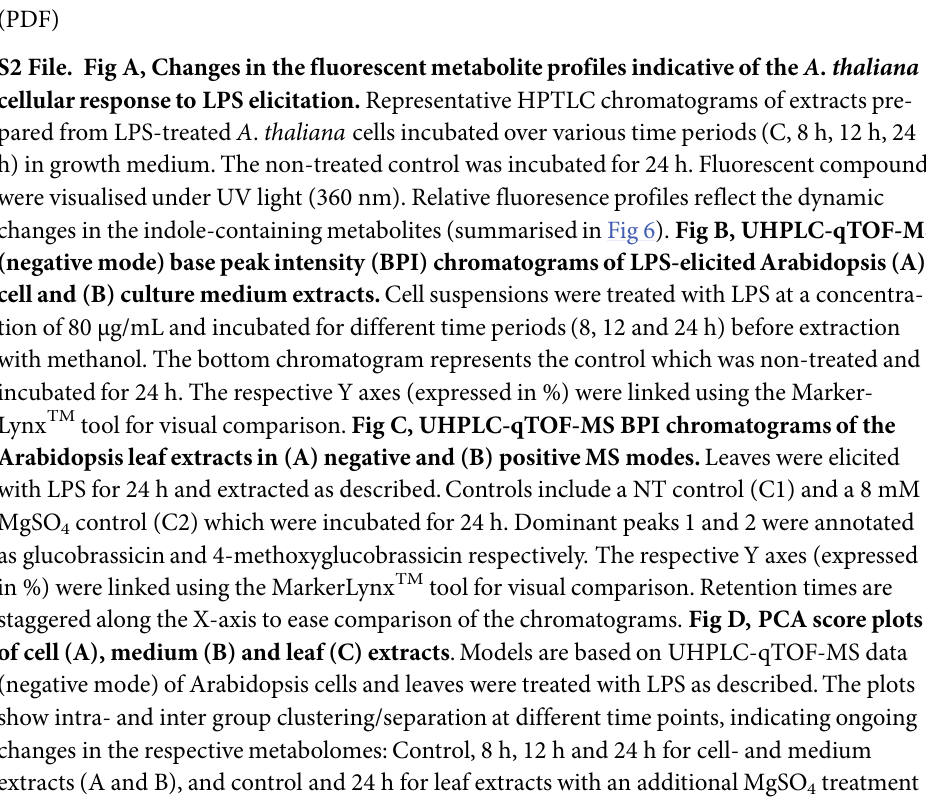
Table C, Quality and reliability of computed PCA and OPLS-DA models. Table D, Table of systematic- and common names for glucosinolates identified in A . thaliana responding to LPS